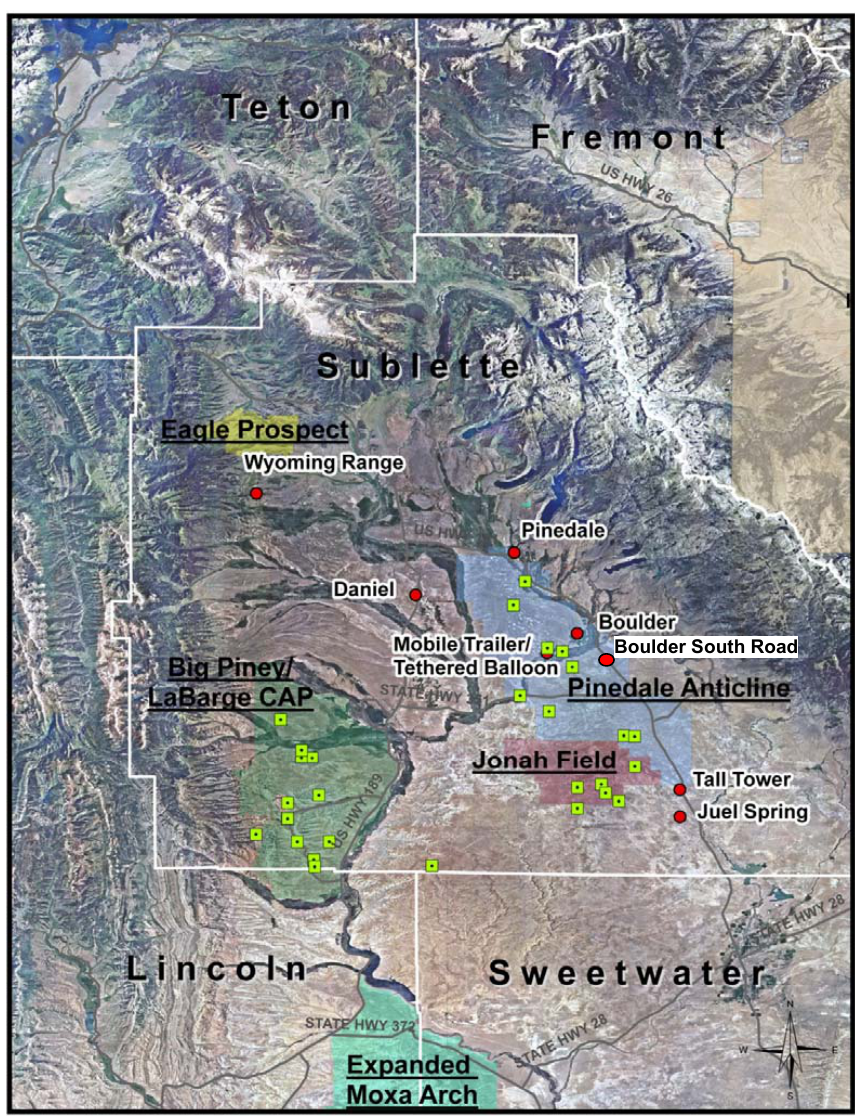
Figure 5. Locations of compressors (green rectangles) operating during the period January–March 2011 relative to the Boulder monitoring